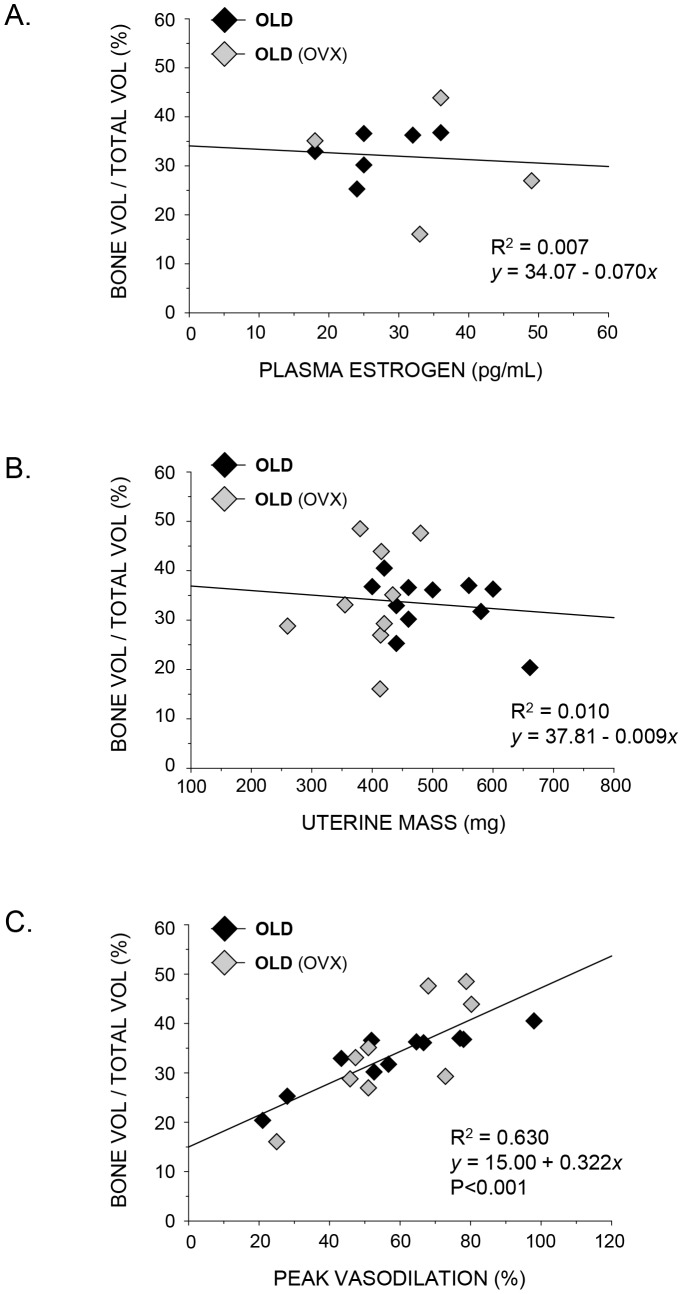
Scattergrams showing the relation between plasma estrogen, uterine mass and endothelium-dependent vasodilation on trabecular bone volume (BV/TV) in the distal femur of old intact and ovariectomized rats.A) plasma estrogen concentration from animals with estrogen levels within the detectable range; B) uterine mass, a biomarker for reproductive hormone concentration; and C) peak endothelium-dependent vasodilation of the femoral PNA. BV/TV was not related to either plasma estrogen (A) or uterine mass (B) in these groups, whereas a significant (P<0.001) linear relation exists between BV/TV and percent PNA vasodilation (C).